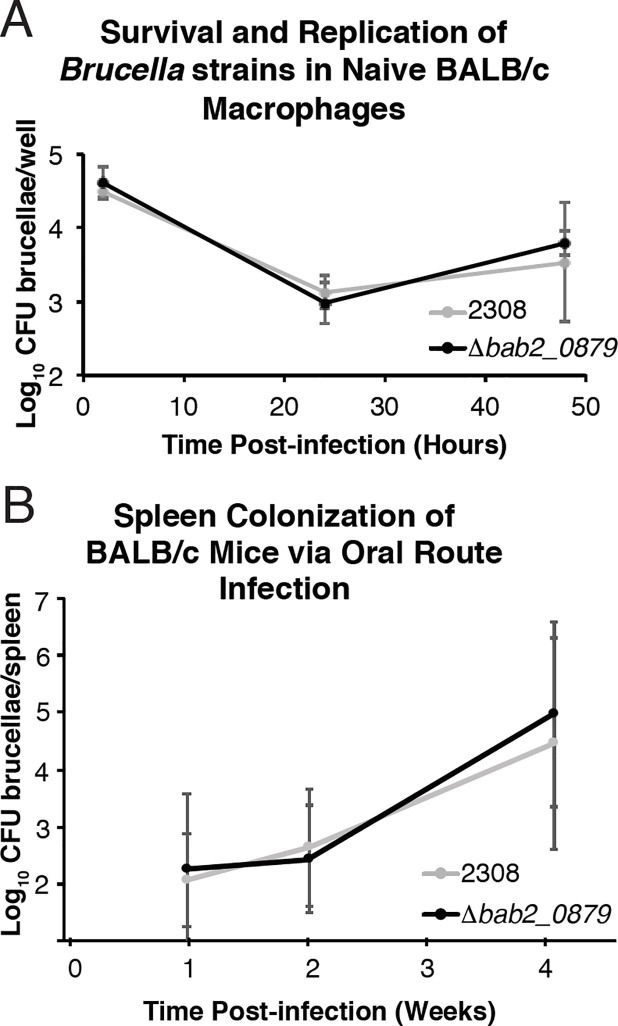
Virulence of B. abortus 2308 and Δbab2_0879 in peritoneally derived macrophages and BALB/c mice.A. Macrophage survival and replication experiments. Cultured peritoneal macrophages from BALB/c mice were infected with B. abortus 2308 and the isogenic bab2_0879 deletion strain (Δbab2_0879). At the indicated times post-infection, macrophages were lysed, and the number of intracellular brucellae present in these phagocytes was determined by serial dilution and plating on agar medium. B. Oral mouse infection experiments. BALB/c mice (6 per strain) were infected intraperitoneally with B. abortus 2308 and Δbab2_0879. Mice were sacrificed 1, 2, and 4 weeks post-infection, and Log10 brucellae/spleen were calculated. The data are presented as average numbers of brucellae ± standard deviations of results from the 6 mice (3 male and 3 female mice) colonized with a specific Brucella strain at each time point.